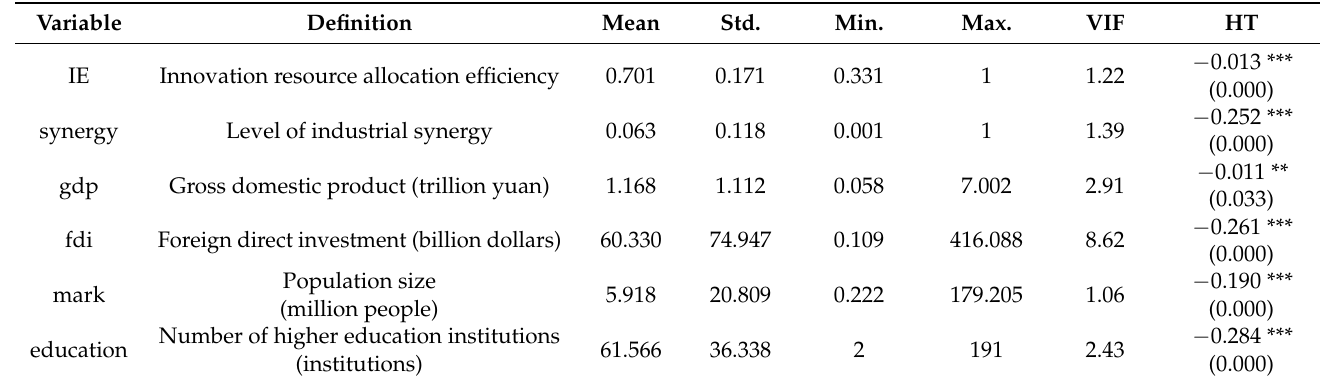
Table 1. Descriptive statistics and testing of